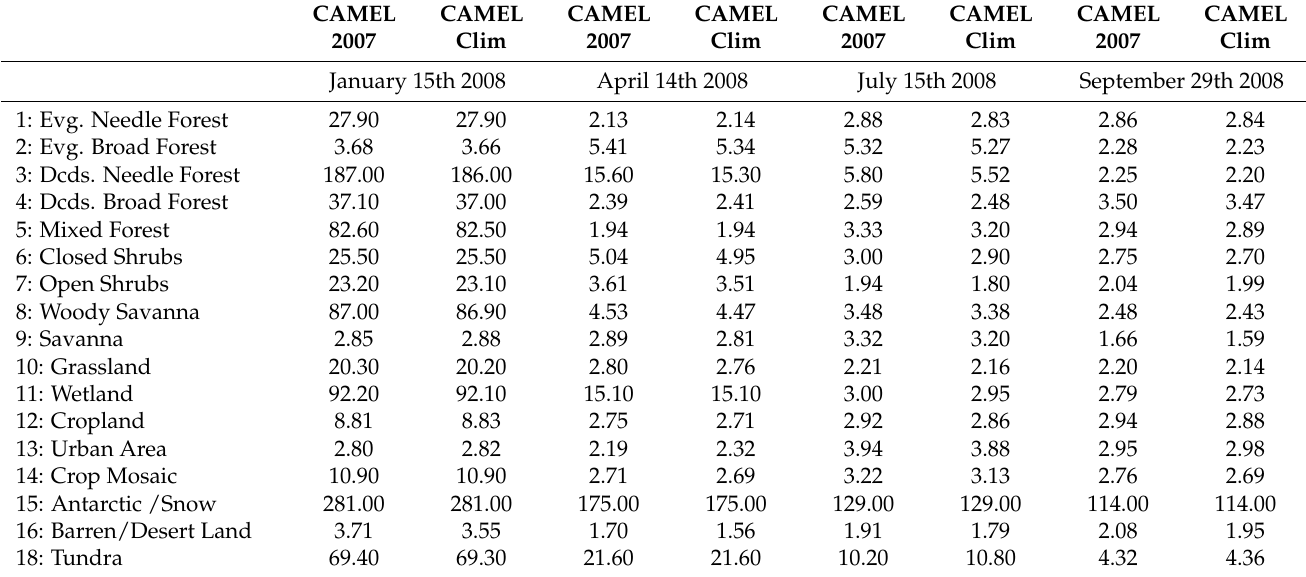
Table 5. Same as Table 3 except for the 3.6–5 µ m region and only nighttime cases.